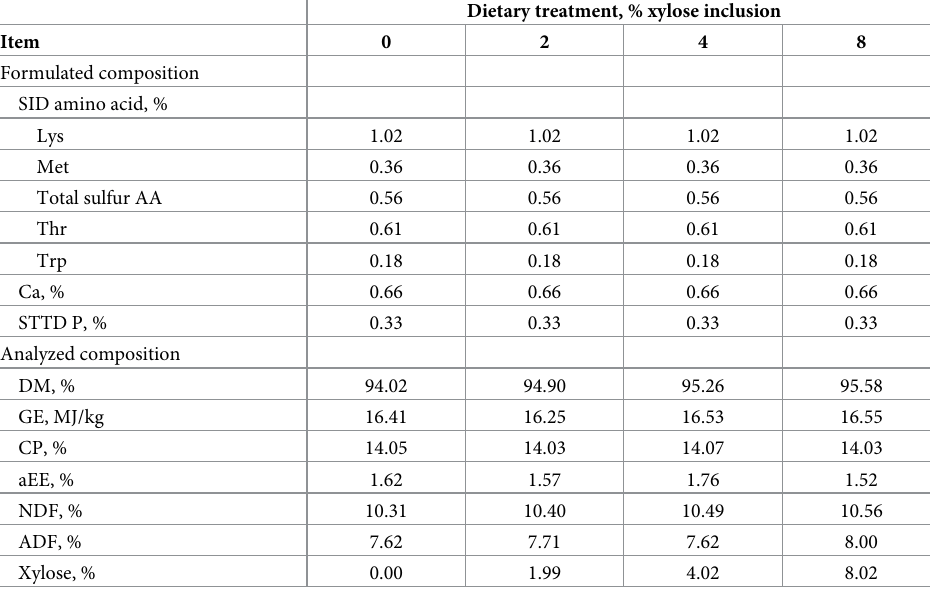
Dietary treatment, % xylose inclusion